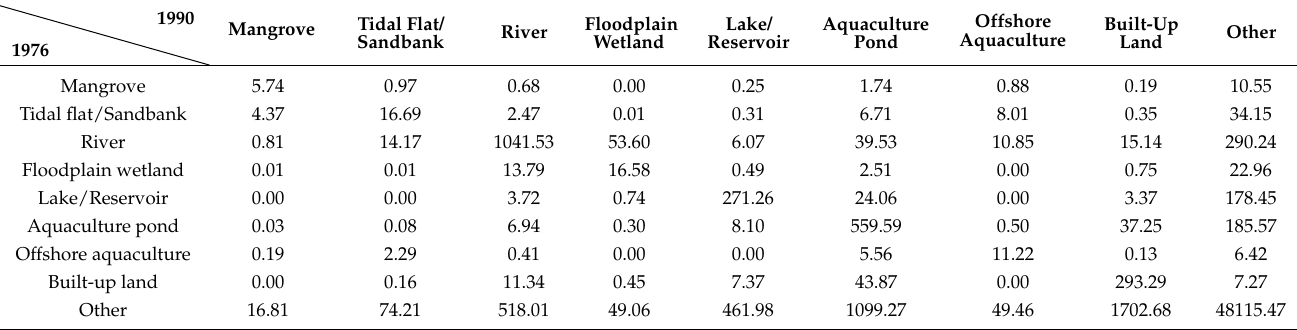
Table A1. Area transfer matrix of each land cover type in the GBA from 1976 to 1990 (km 2 ).